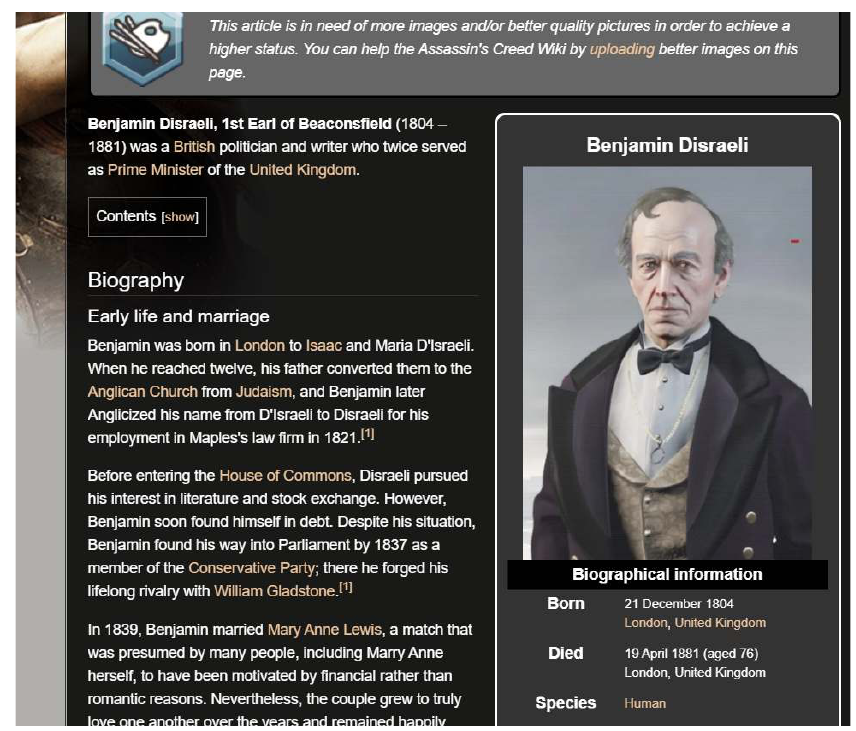
Figure 13: A screenshot of the article for Benjamin Disraeli in the Wikia for Assassin's Creed Syndicate